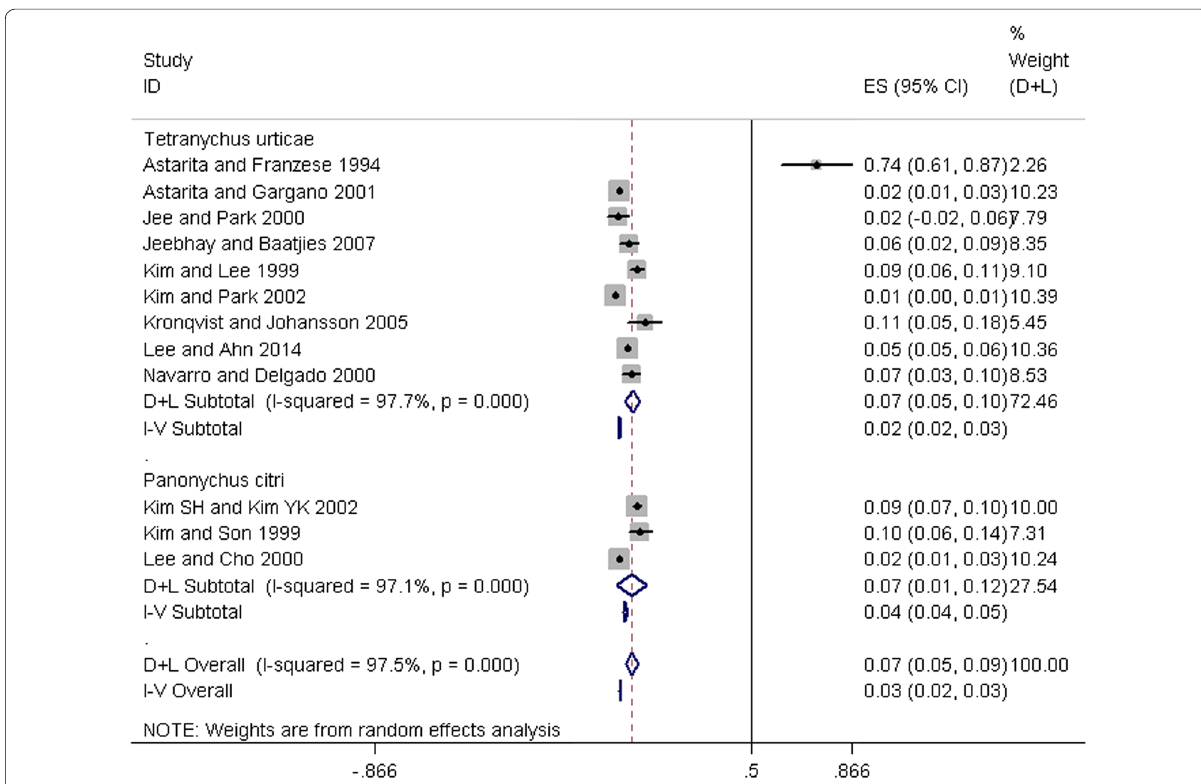
Fig. 5 Forest plot of prevalence estimates of monosensitization of spider mite sensitization from included